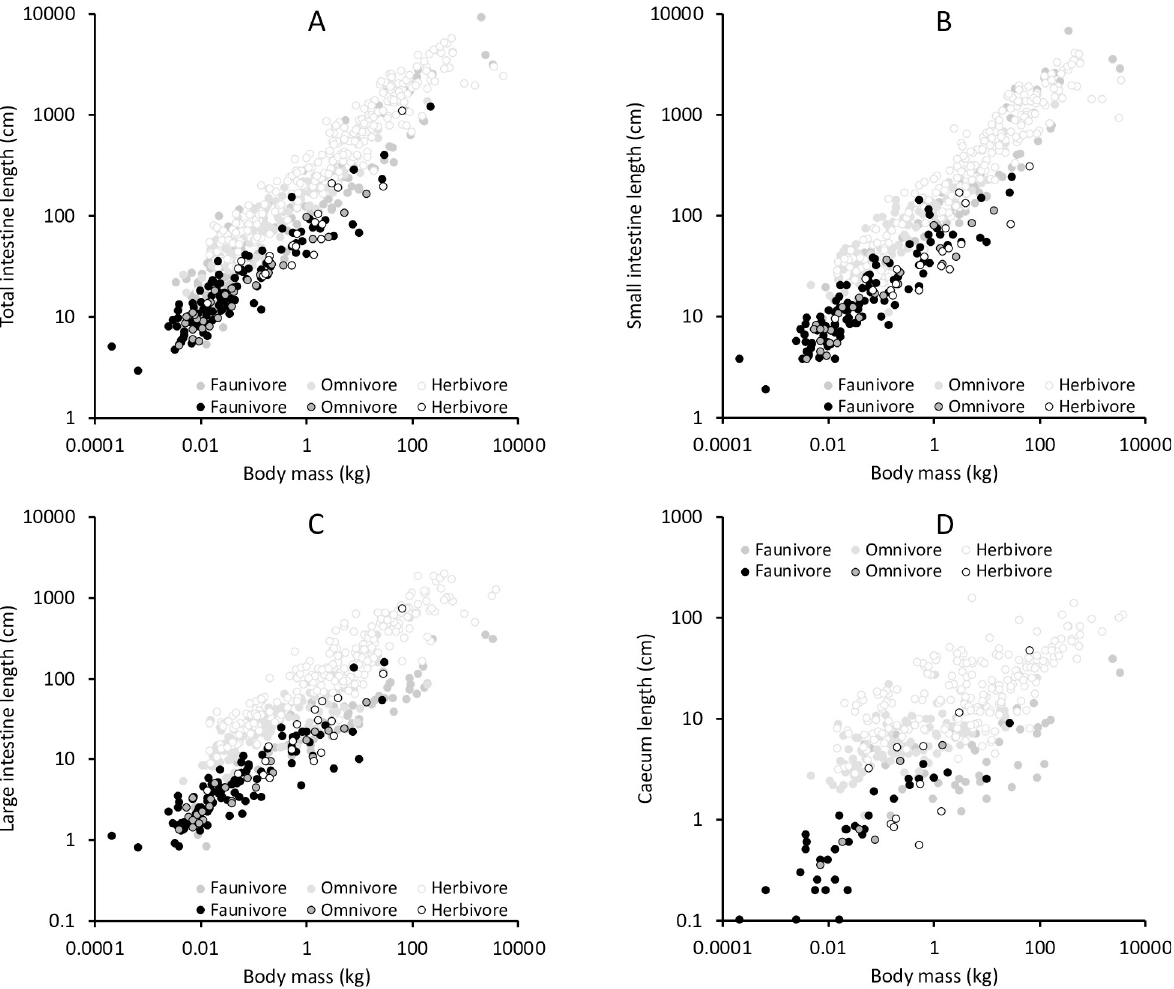
Fig 3. Relationship of body mass, intestinal length and trophic level in reptiles for (A) total intestine (n = 157 species), (B) small intestine (n = 147), (C) large intestine (Caecum and colon) (n = 141), (D) caecum (n = 52), as compared to mammals (light grey symbols). For statistics, see S3-S5 Tables in S1 File. Mammal data from